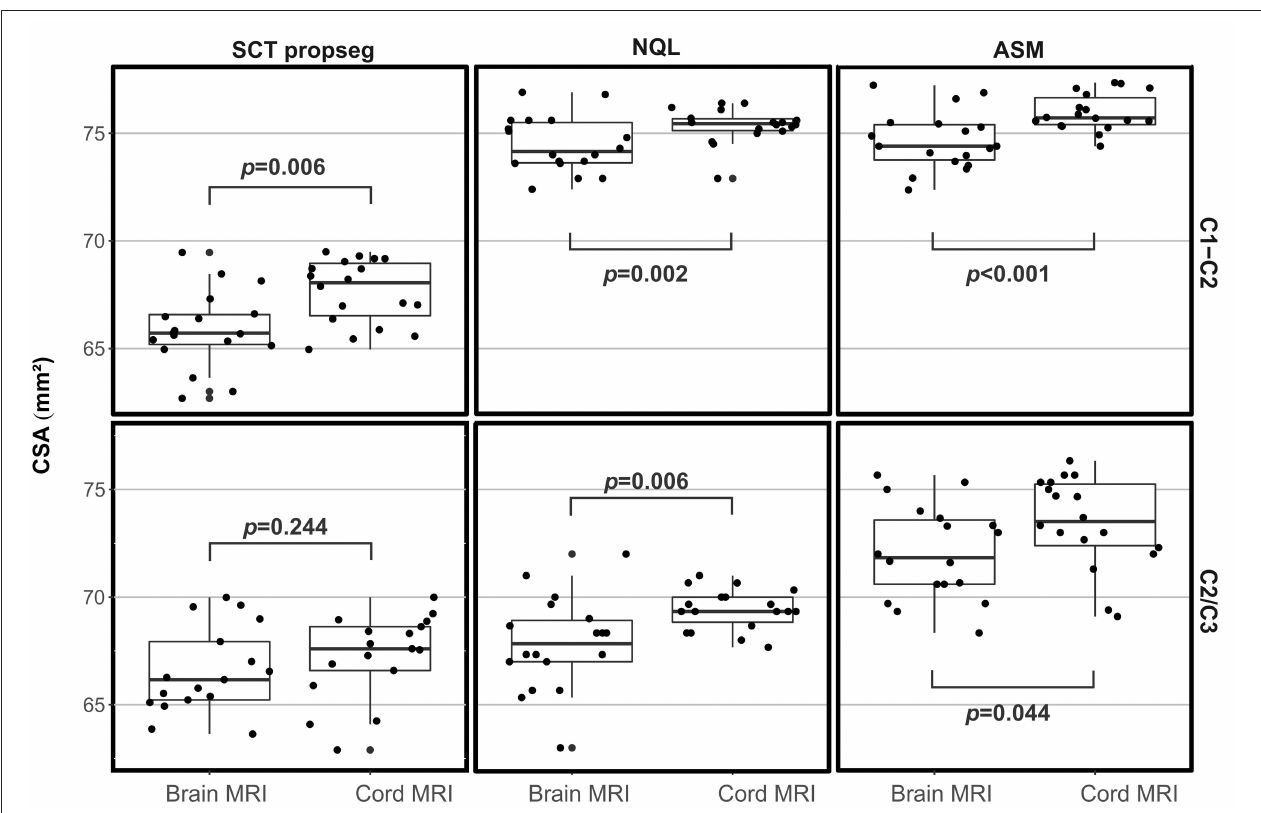
FIGURE 5 | Cross-sectional area (CSA) across all centers based on brain or cord MRI using three different software methods at the C1–C2 or the C2/C3 vertebral level. Significance of group differences assessed using univariate ANOVAs with CSA as dependent variable and MRI acquisition type and scan repetition number as fixed